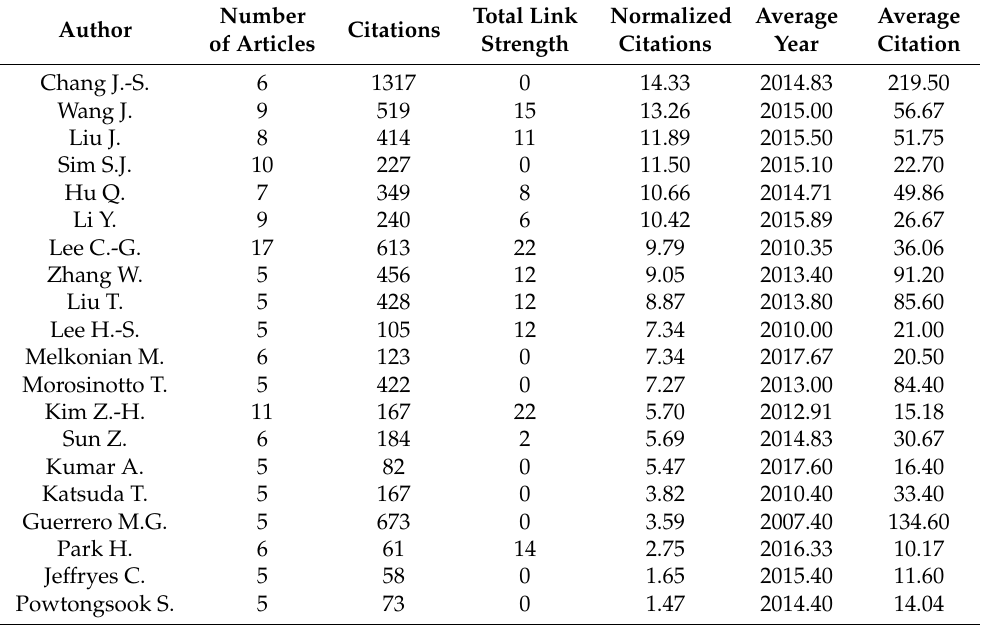
Table 1. Authors with high article impacts based on normalized citations (min.